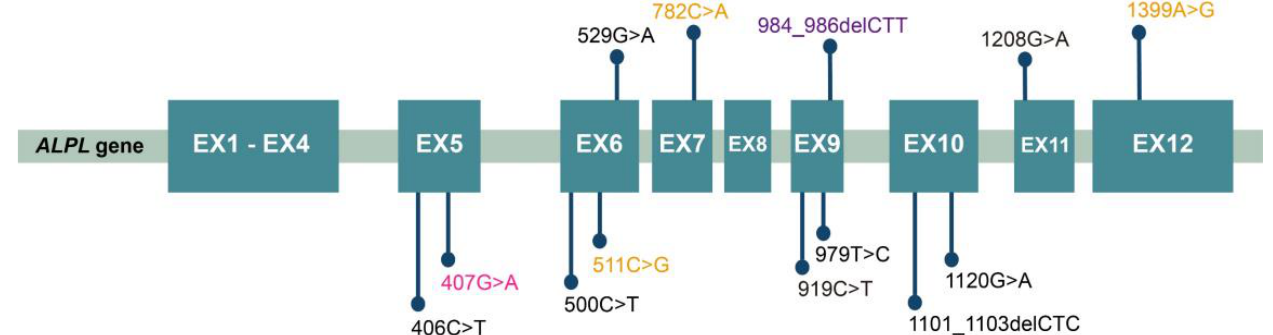
Figure 3. The mutation spectrum of ALPL in all patients. Mutations repeated three times are shown in rose red. Mutations repeated twice are shown in purple. Yellow font indicates the novel mutations first reported in the current study. Note:Intrafamilial repetition of the same mutation was regarded as appearing once.